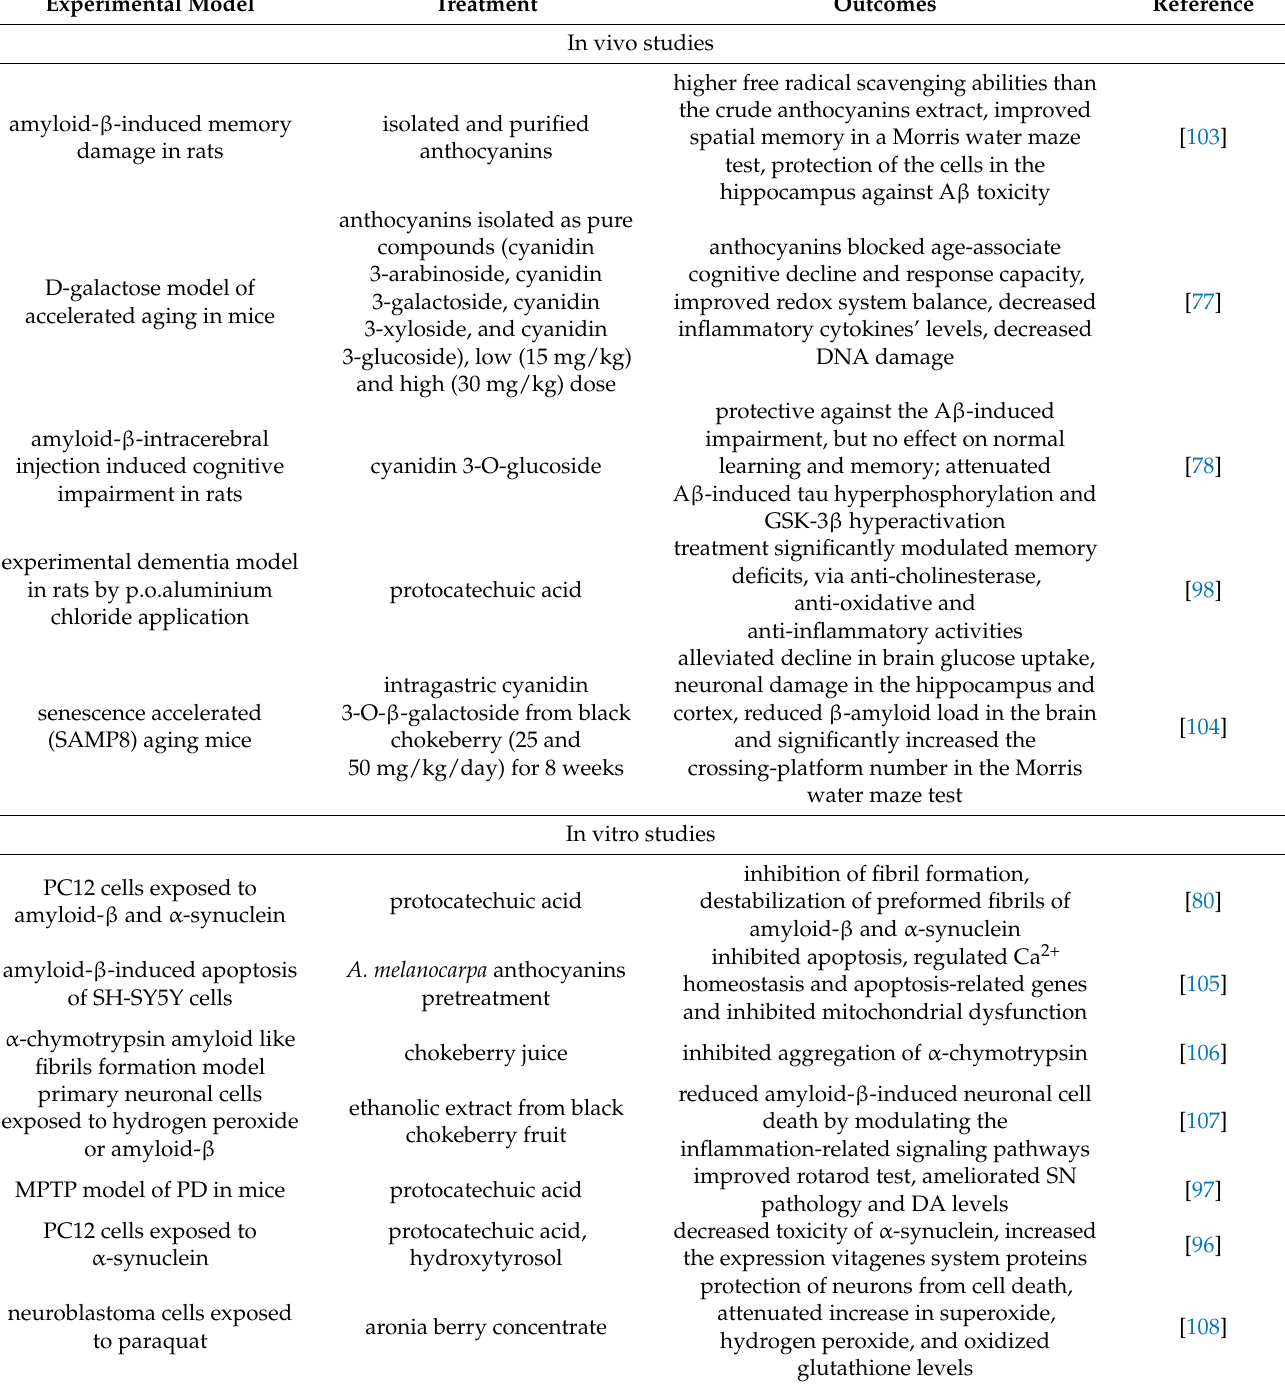
Table 2. Selected recent preclinical studies on the neuroprotective effects of aronia berry extracts, anthocyanins, and their metabolites in experimental models associated with Alzheimer’s and Parkin- son’s